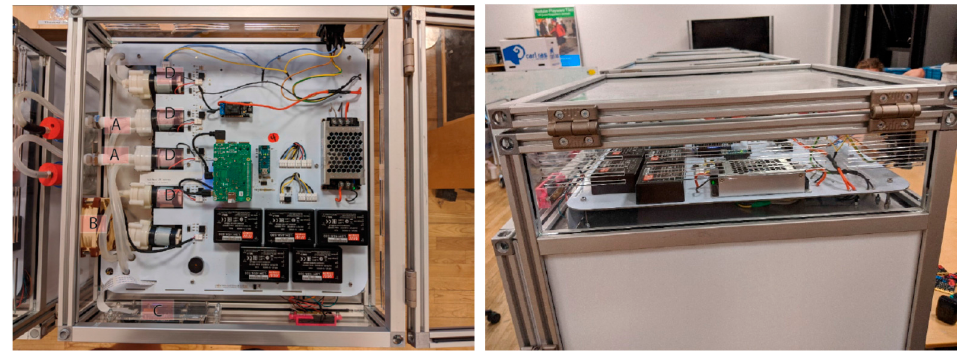
Figure 3. Left : Top view of the GrowBot, and Right : side view of the GrowBot upper layer with the electronics.